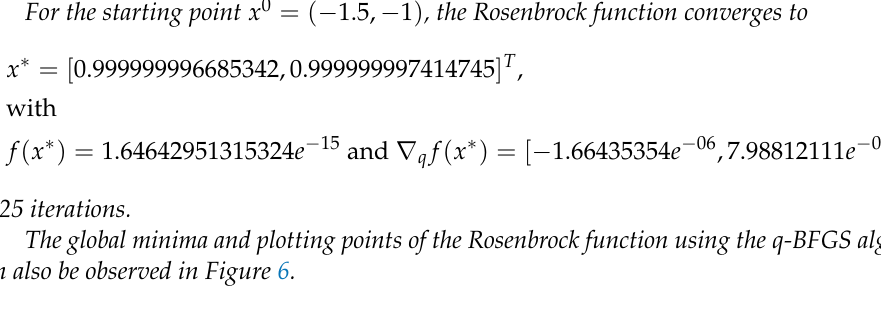
Figure 5. Global minima of the Rosenbrock function using modified q -BFGS